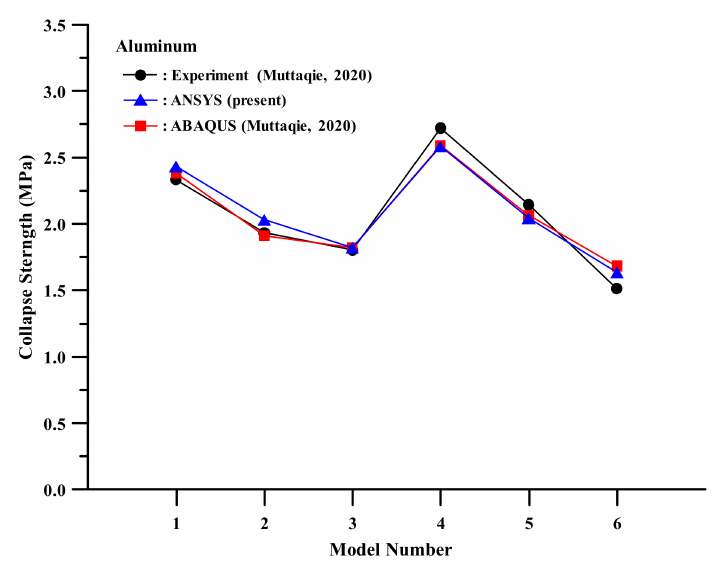
Figure 3. Comparison of collapse strength obtained for the aluminum material. Table 3. Summary of collapse strength obtained for the aluminum material.